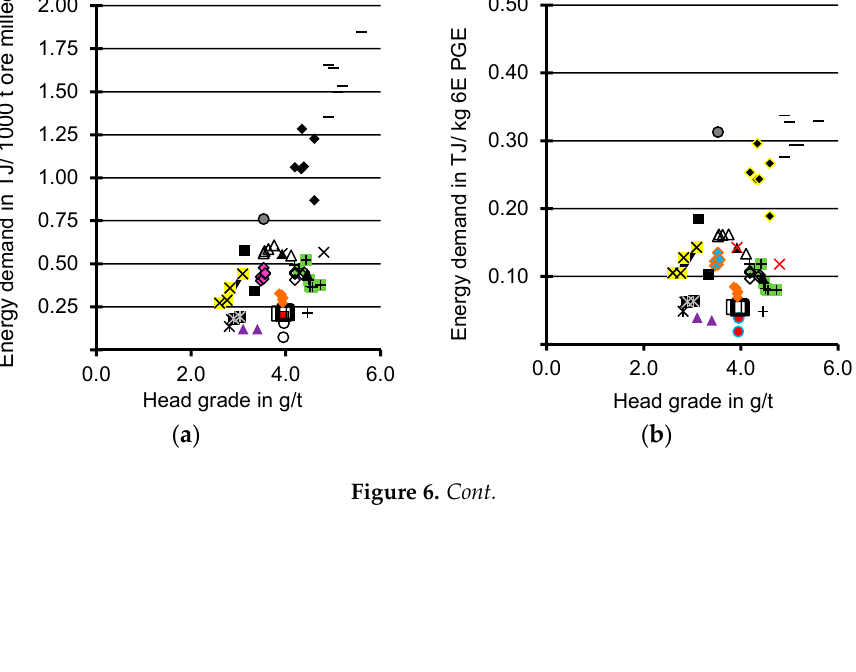
( d ) Figure 6. Energy demand per 1000 t ore milled and per kg 6E PGE production plotted over head grade ( a , b ); and per 1000 t ore milled plotted over mine depth ( c ); and the share of UG2 processed ( d ). Data from 2010 to 2015. Regression lines and related R 2 can be found in Figures S2–S7. Abbreviations: MC: Mine and concentrator; MCS: Mine, Concentrator and Smelter. Based on data from [59–62,68,69,73,75,85–89].